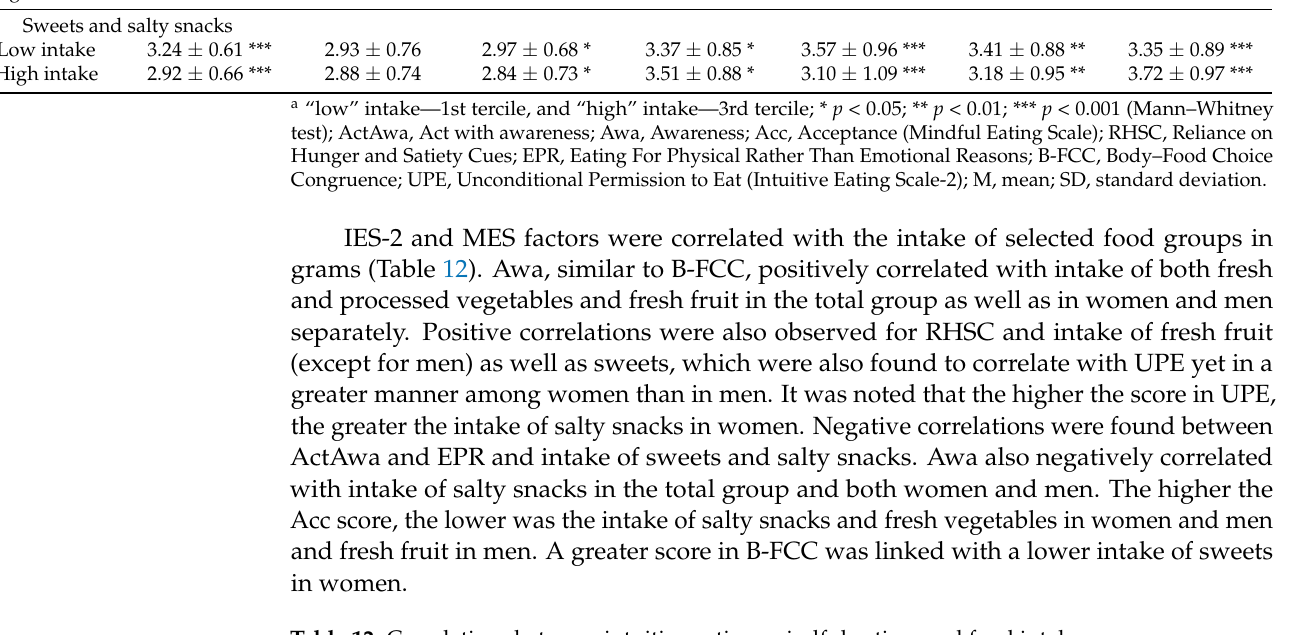
Table 12. Correlations between intuitive eating, mindful eating, and food